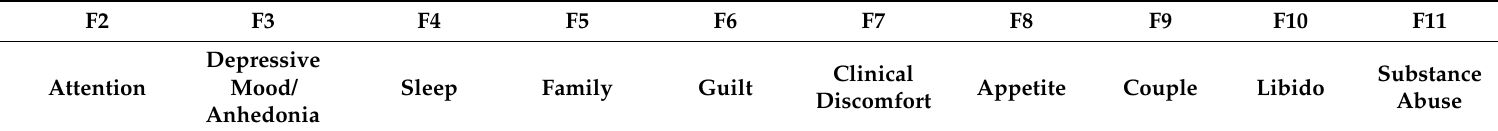
Table A2. Saturations and factorial structure of the DCET items at the moment “year” (N =